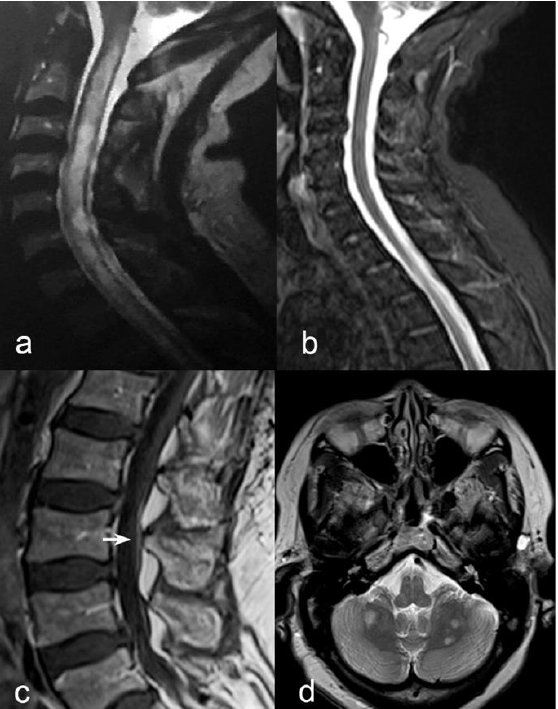
Figure 1. ( a ) Sagittal T2-weighted MRI of the cervical spine in the acute phase showing heterogeneous hyperintensity from C2 to the first thoracic segments with predominant central involvement. ( b ) 1-year after onset, sagittal STIR-T2-weighted MRI of cervical spine showed absence of previously seen inflammatory lesions. ( c ) Contrast enhancement of cauda equina roots (white arrow) was observed in sagittal T1-weighted sequences after Gadolinium administration. ( d ) Multiple bilateral round-shaped inflammatory lesions in cerebellar white matter were evident on axial T2-weighted axial scan ( d ).